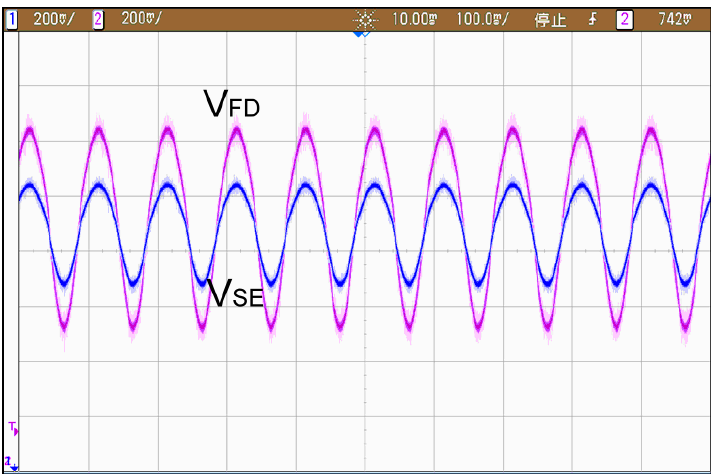
Figure 14. Output swing of SE and FD